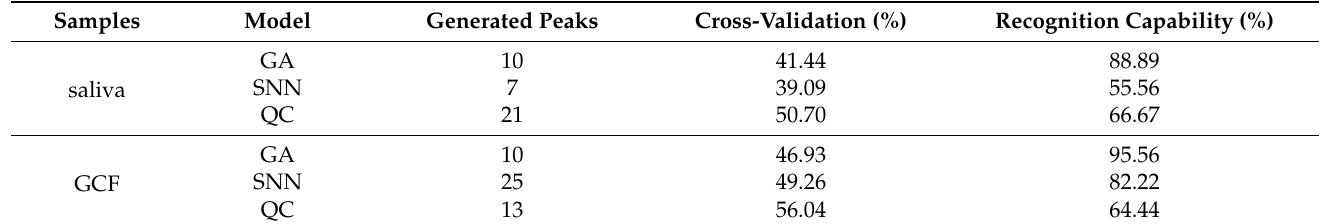
Table 1. Results of a cross-validation test and recognition capability test of the GA, SNN, and QC models to distinguish the three groups (control, FOA, and IN) in the whole saliva and GCF samples.